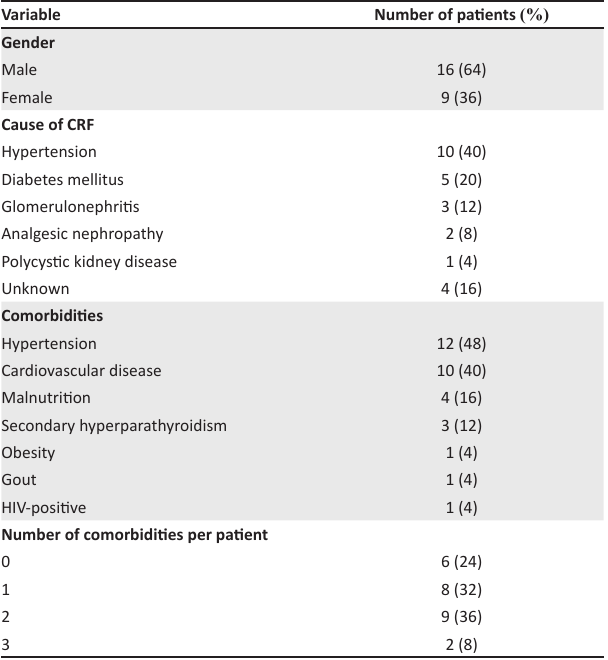
TABLE 1: Patient demographics and clinical characteristics. TABLE 2: Complications within 30 days.